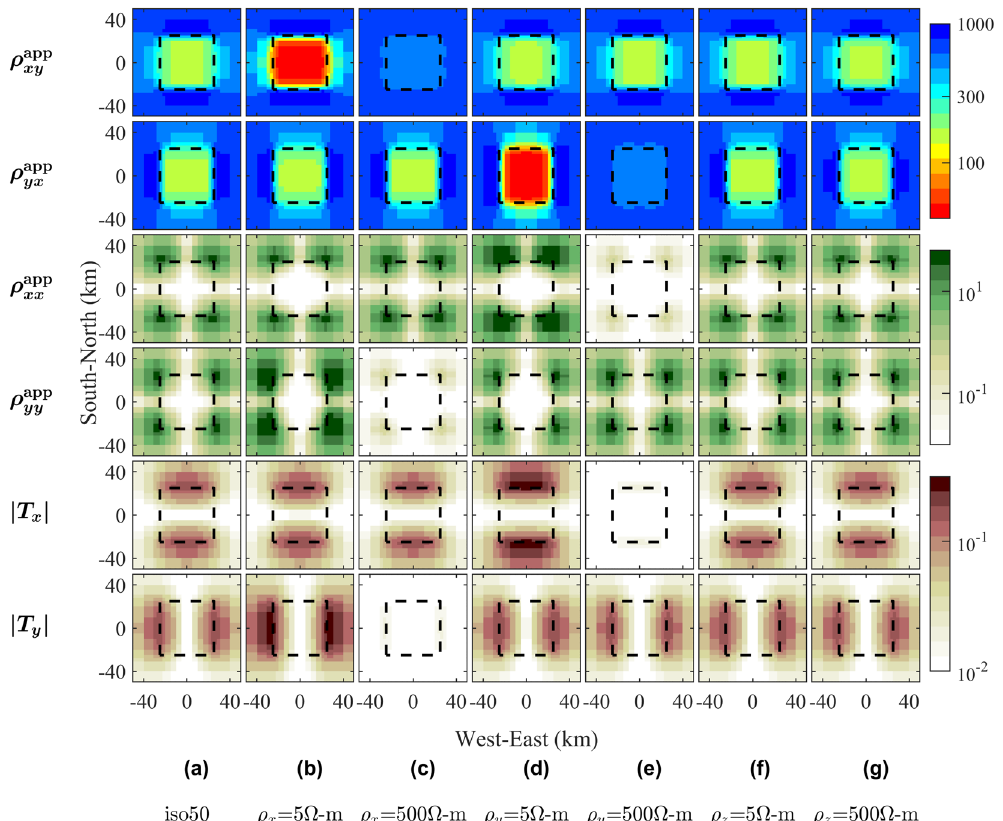
Fig. 15 The surface plots of the apparent resistivities ρ app xy , ρ app yx , ρ app xx , and ρ app yy and the magnitude of the tipper | T x | and , respectively, from top to bottom rows, at a period of 10 s from a the isotropic case of ρ